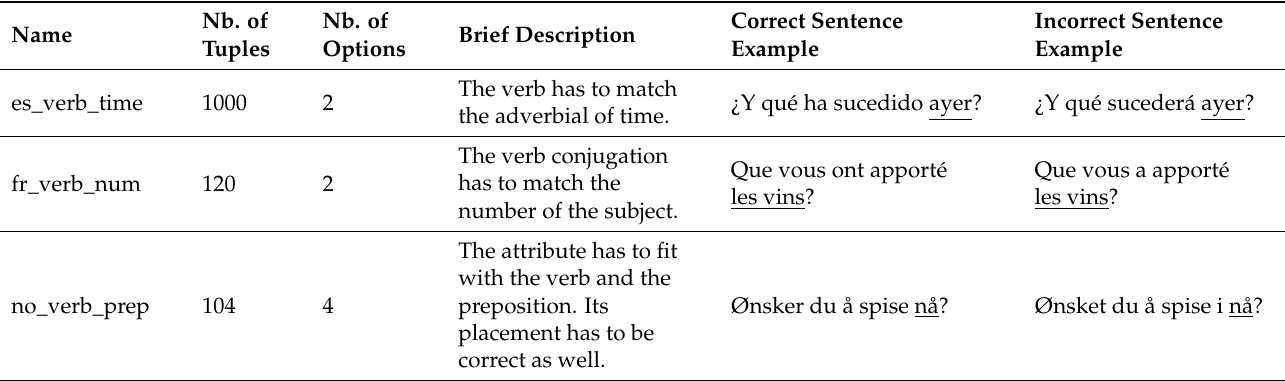
Table 9. Examples of tasks to analyse the LMs’ performance at selecting the correct template given an attribute. In the examples, the attribute is underlined. All tasks are in Table A1 of Appendix